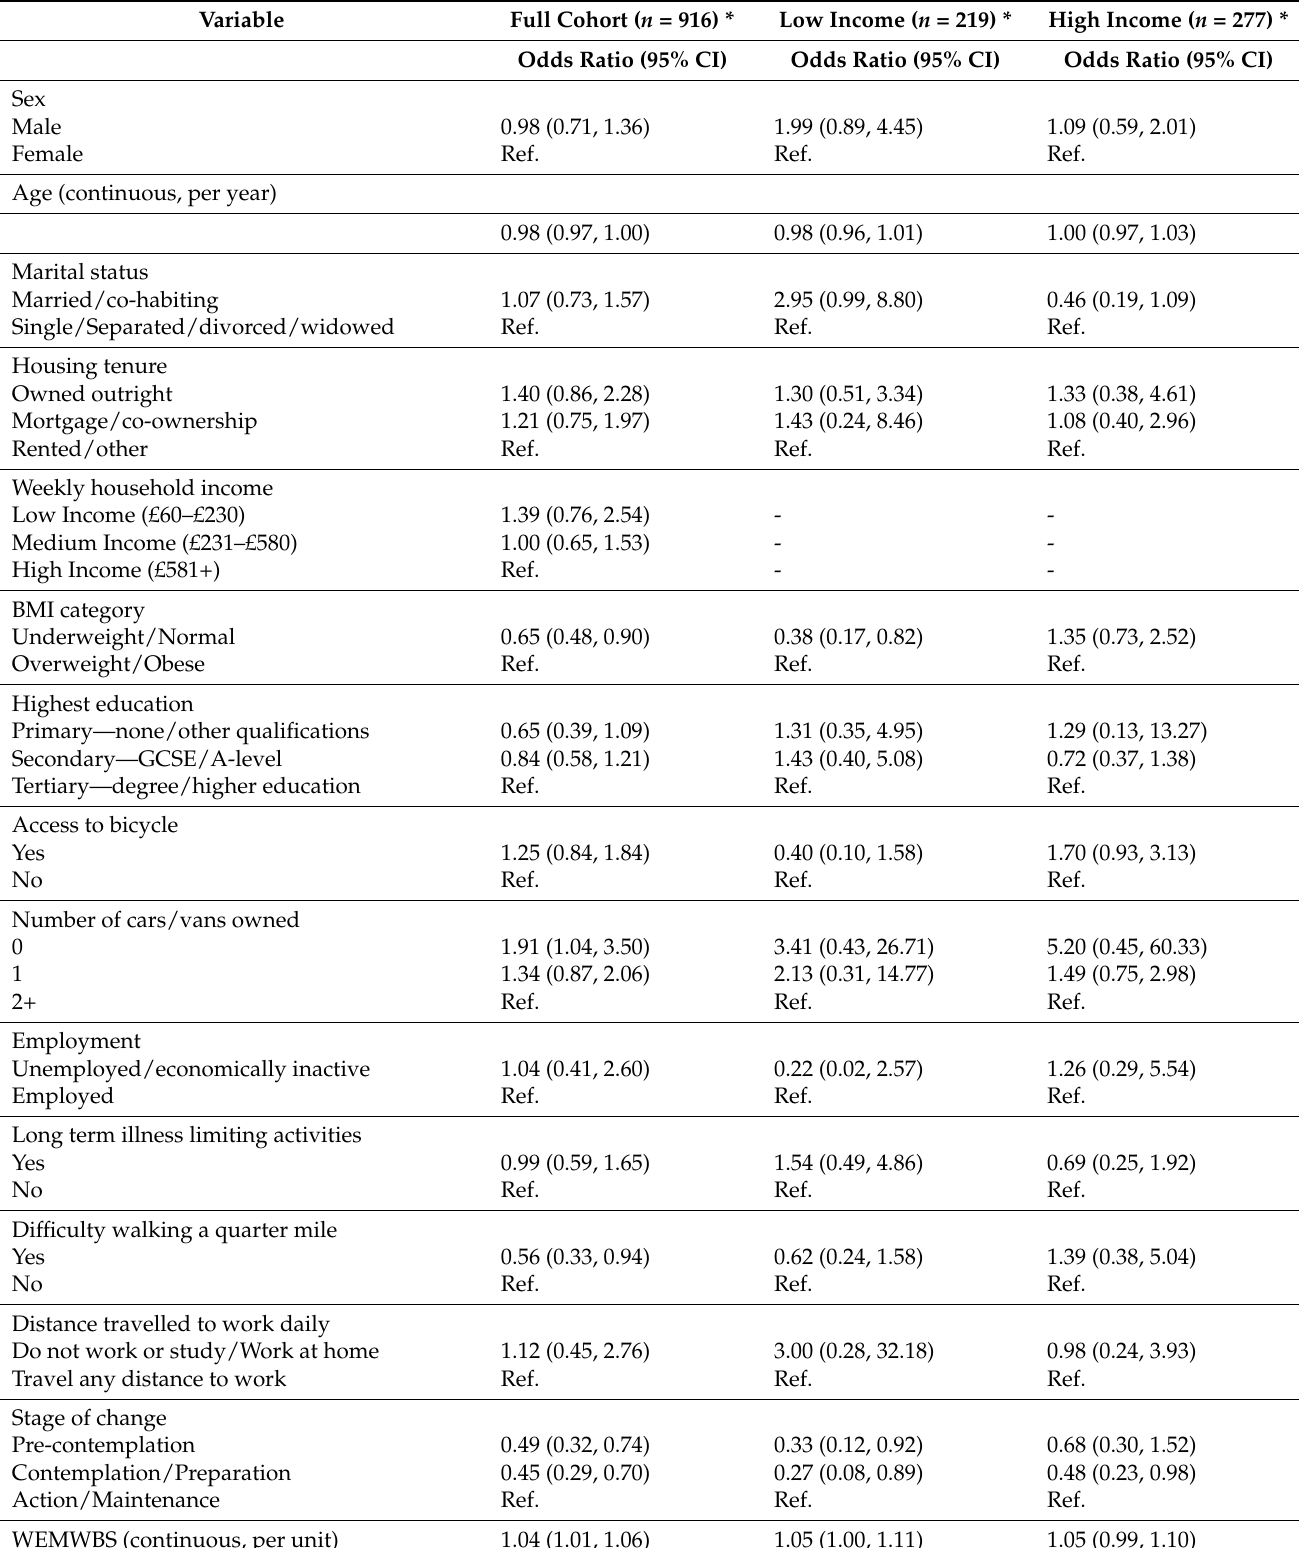
Table 3. Multiple logistic regression of socio-demographic, health, environmental and psychological associations of none/some active travel (binary) for full cohort and by low and high